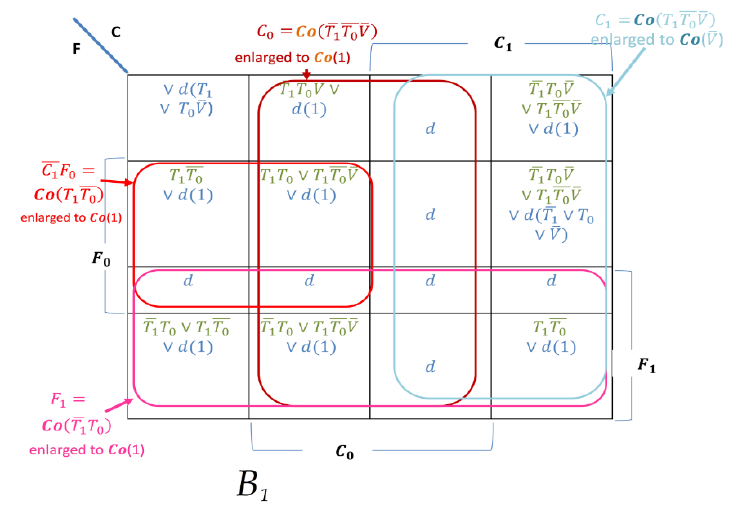
Fig. 11. Reading the VEKM in Fig. 8 to obtain formula